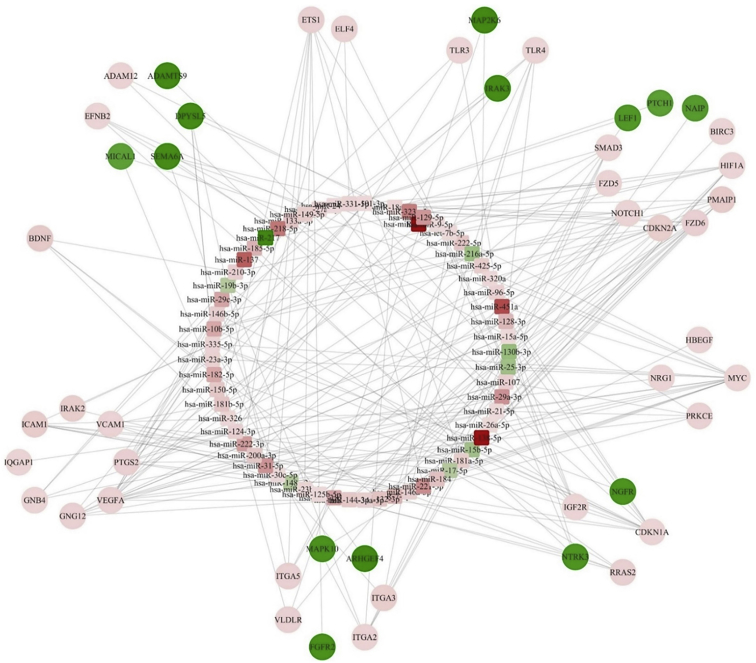
Molecular Network Identified by IPA between mRNA and miRNA in MBThe rectangle represents the miRNAs, and circles represent the mRNAs. Green represents upregulated miRNA and genes, and red represents downregulated miRNA and genes. The intensity of the respective colors indicates the fold expression (more intense green indicates more upregulation and vice versa; similar is for red annotation).